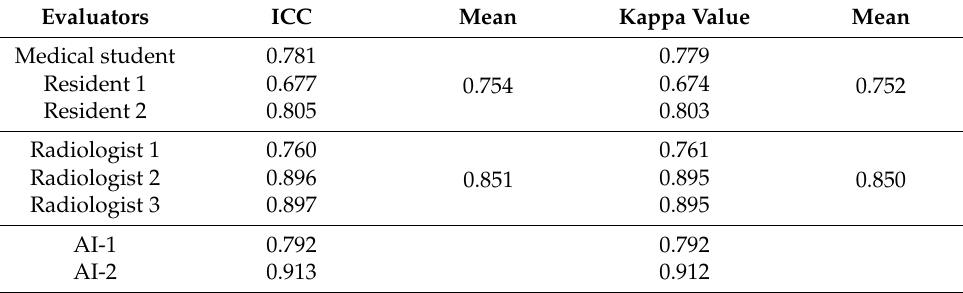
Table 3. Agreement with the CO-RADS score for each evaluator.